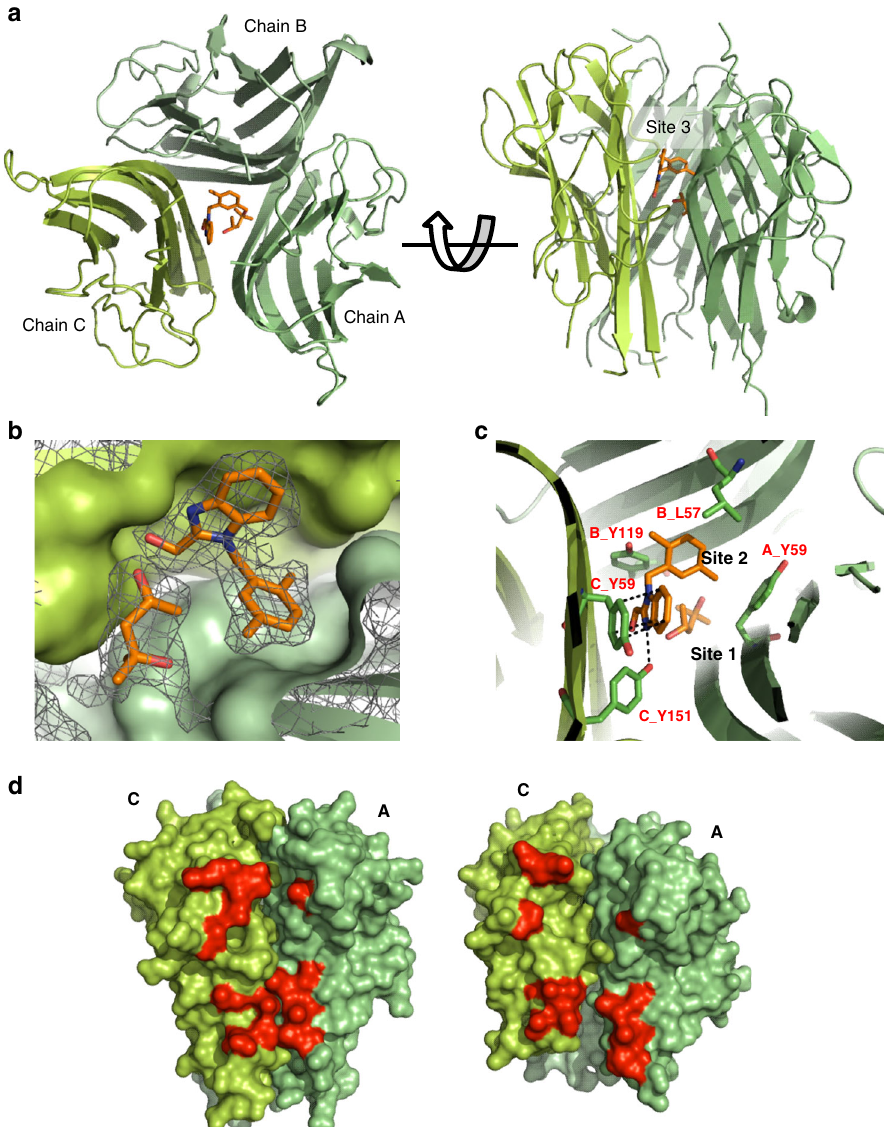
Fig. 2 Crystal structure of human TNF with UCB-6876. a Top and side views of TNF (green ribbons) with UCB- 6876 bound (orange sticks). b Detail showing the electron density of UCB- 6876 and MPD bound within the TNF homotrimer. Monomers B (light green) and C (green) are shown surface rendered. Contour level of the electron density is set at 1 sigma. MPD occupies a space next to UCB- 6876 . Subsequent molecules described in this paper were modi fi ed to have chemical groups occupying the space where MPD was bound. c Detail of the compound-binding pocket within the TNF homotrimer, with key residues involved in binding highlighted (sticks and labels). d Side view of apo-TNF (left image) and UCB- 6876 bound TNF (right image) revealing the distorted AC receptor-binding site (selected residues involved in TNFR1 binding are highlighted